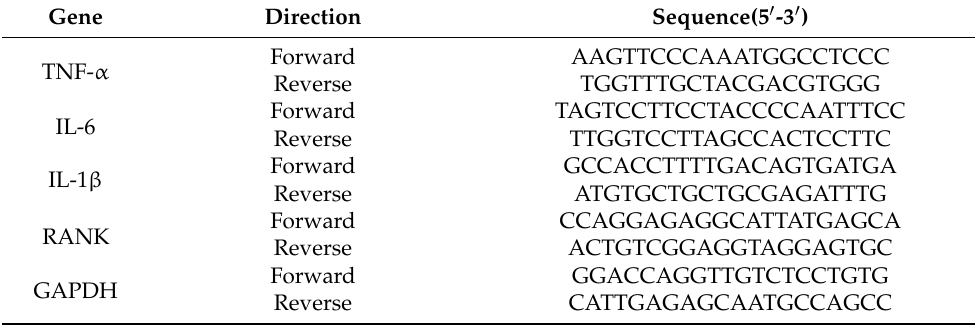
Table 1. The primer sequences of macrophages for